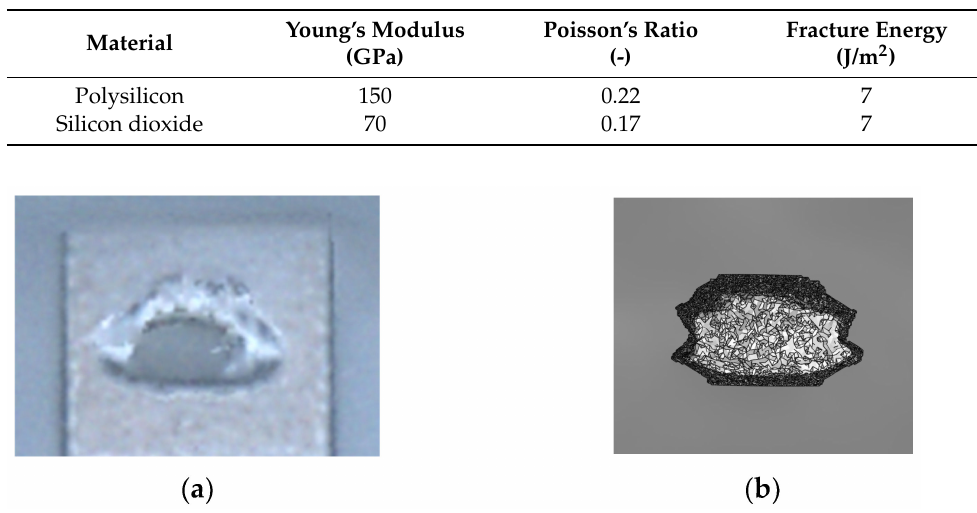
Figure 6. ( a ) Detail of Figure 6 showing a top view of the experimental fracture profile, and ( b ) result of the corresponding FE